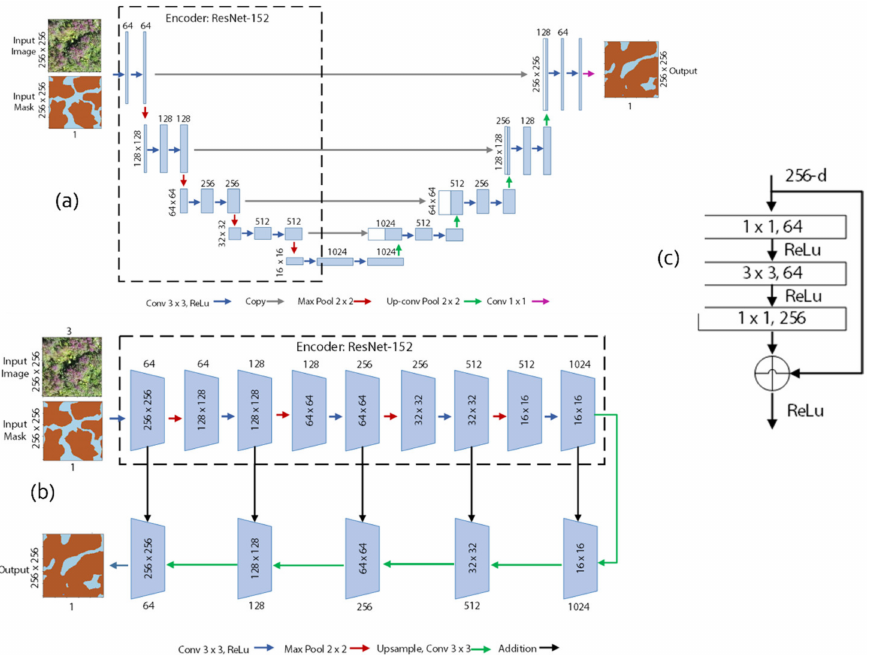
Figure 4. U-Net ( a ) and LinkNet ( b ) architecture with the ResNet-152 encoder. ( c ) A building block for the ResNet-152